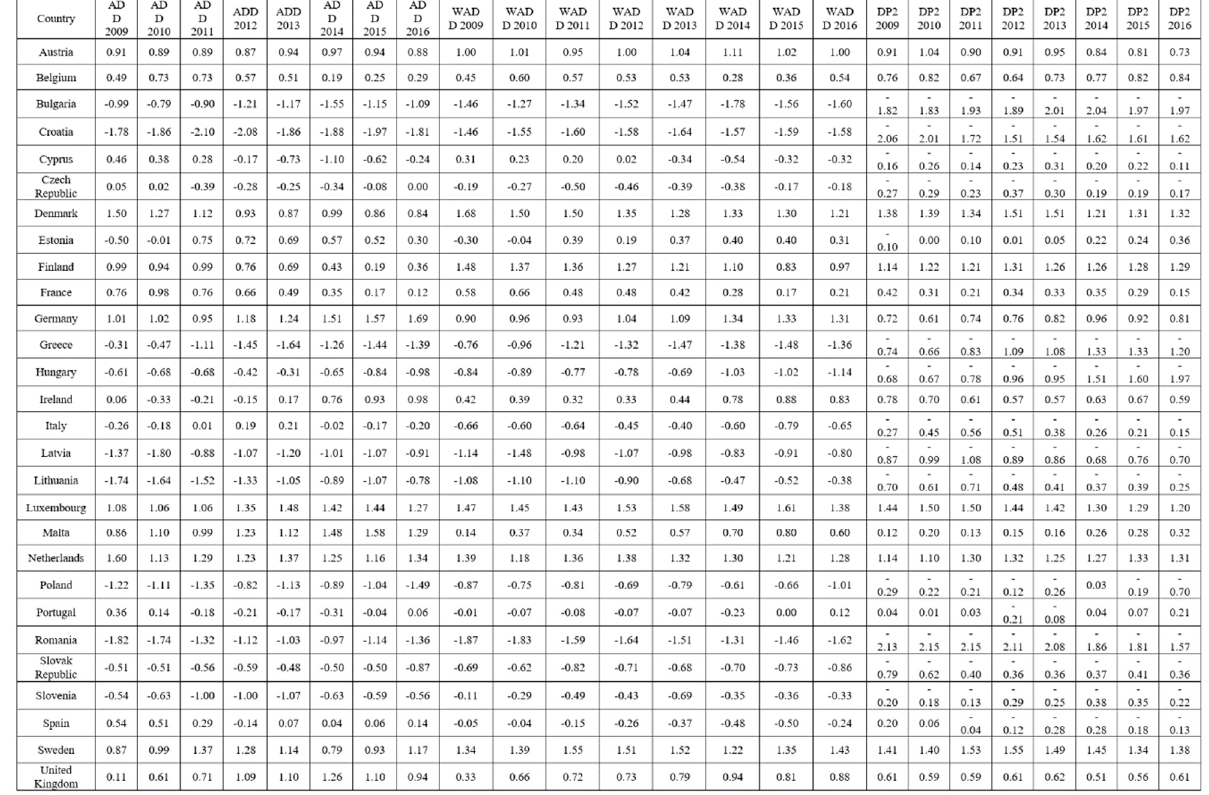
Figure A2. Appendix: indexes results matrix.